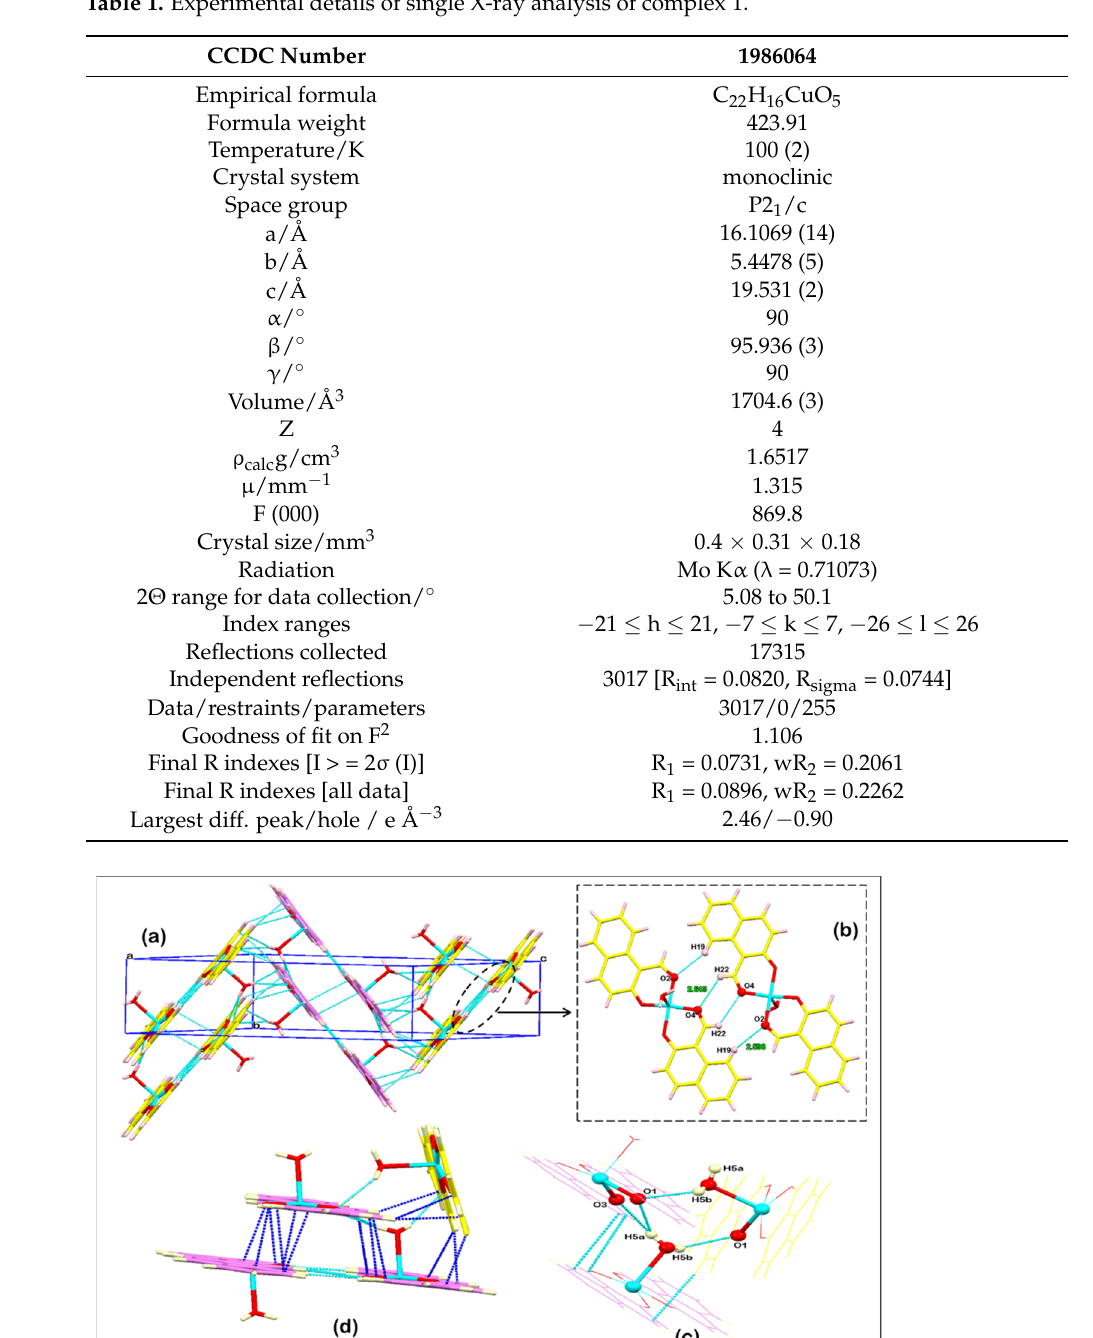
Table 1. Experimental details of single X-ray analysis of complex 1.